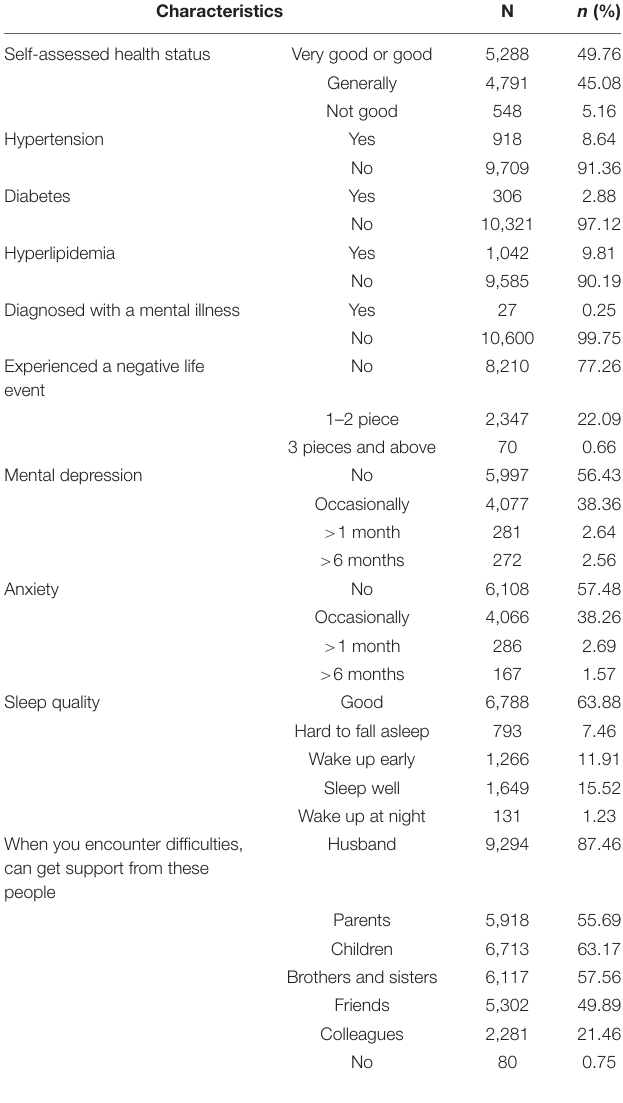
TABLE 4 | Health-related emotional factors of cervical cancer screening population.